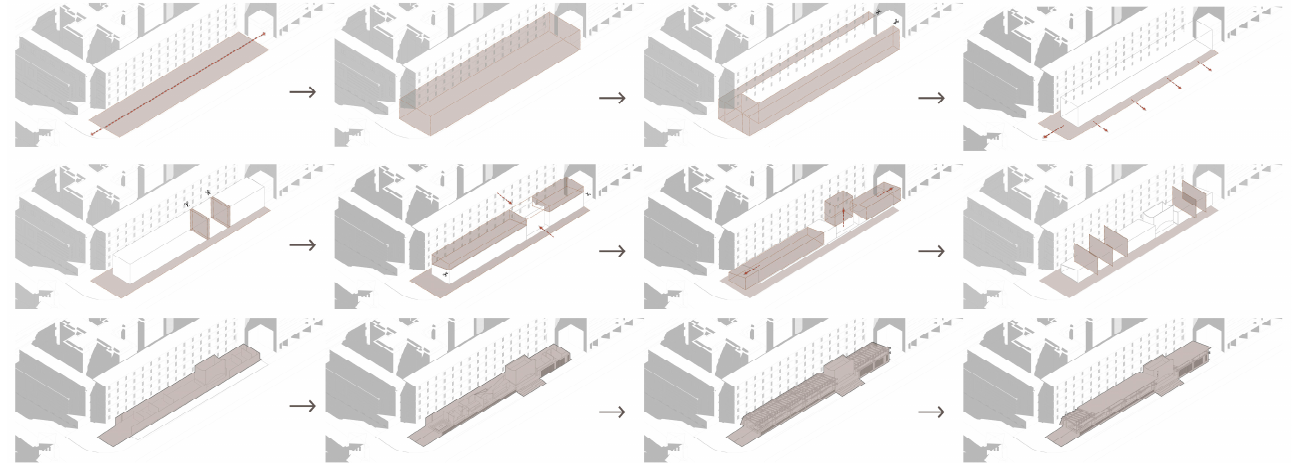
Figure 10. Logic Diagram of Building Form-Creation.